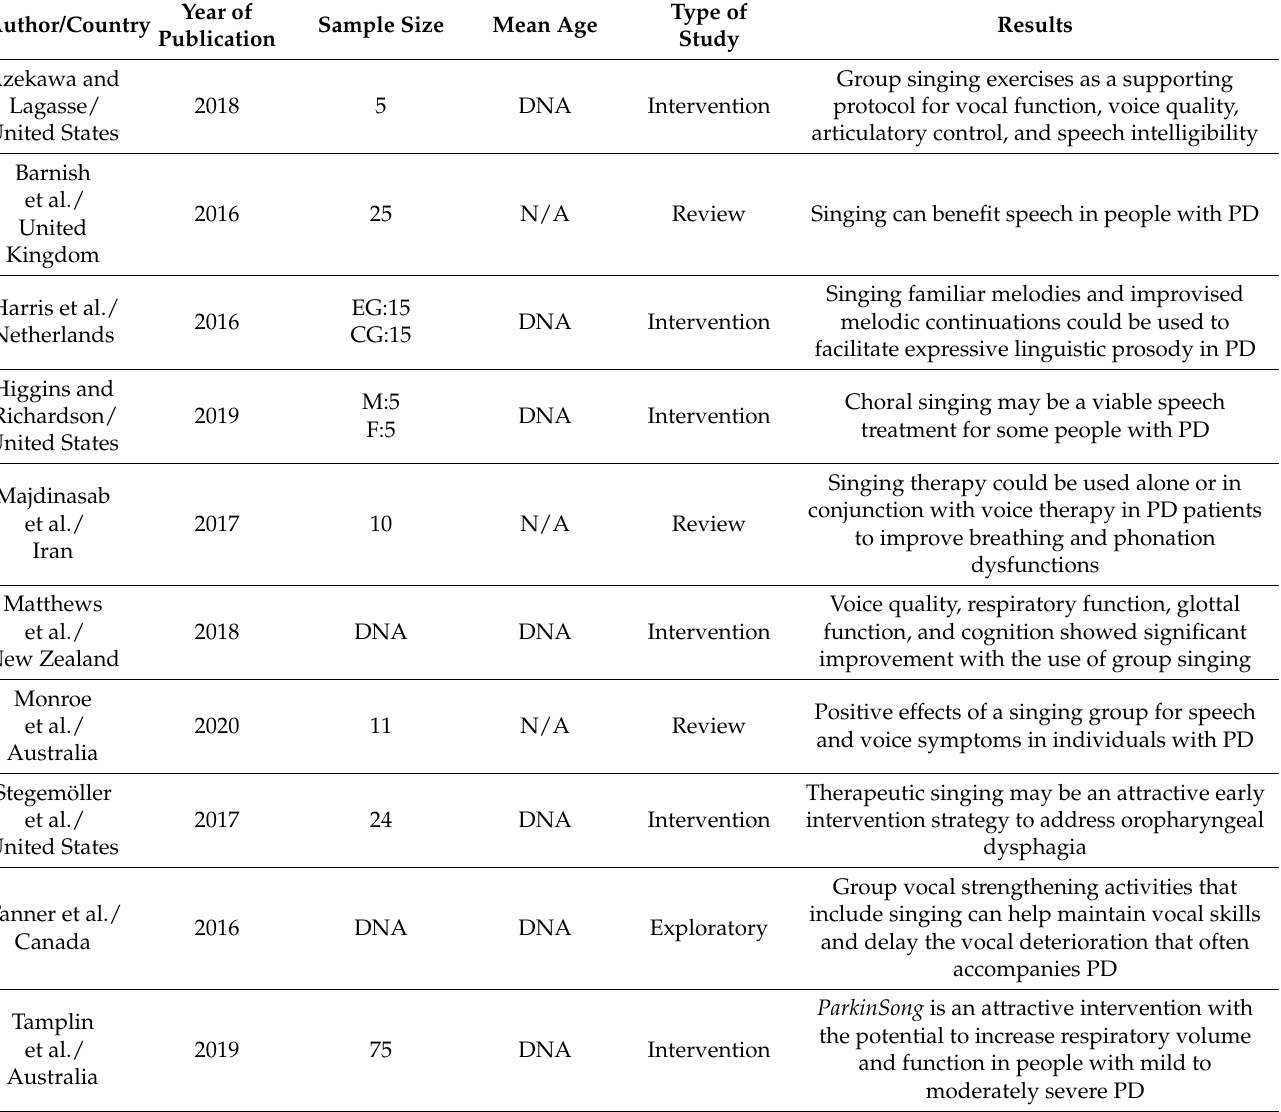
Table 5. Articles addressing the effects of music therapy on the social and communication sphere.